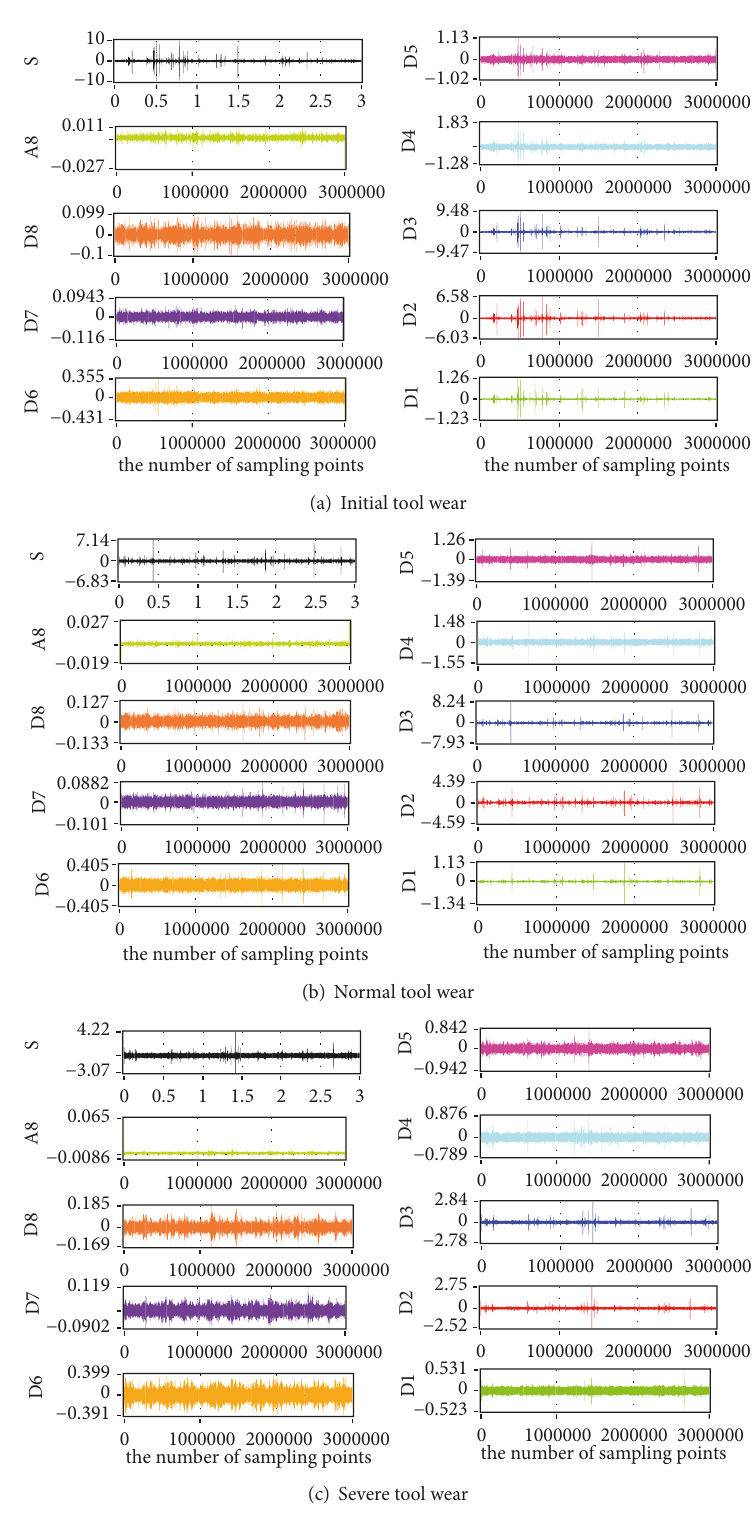
Figure 16: Waveforms of AE signal by wavelet multiresolution decompositions (cutting speed 64.6m/min; feed speed 0.11mm/r; depth of cut